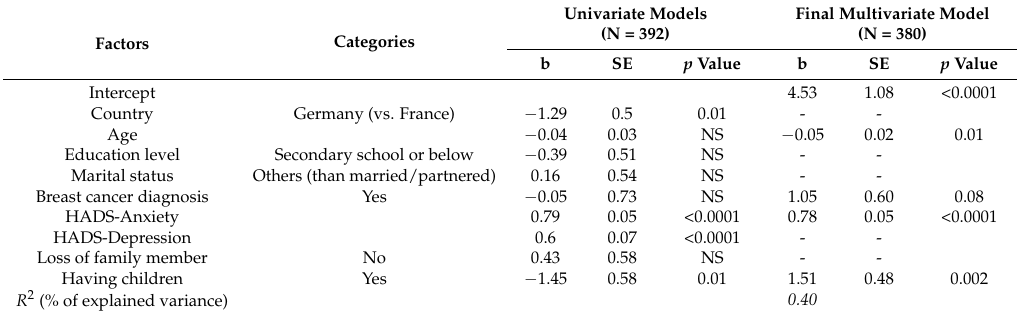
Table 3. Multiple regression results of factors associated with the number of psychosocial needs.